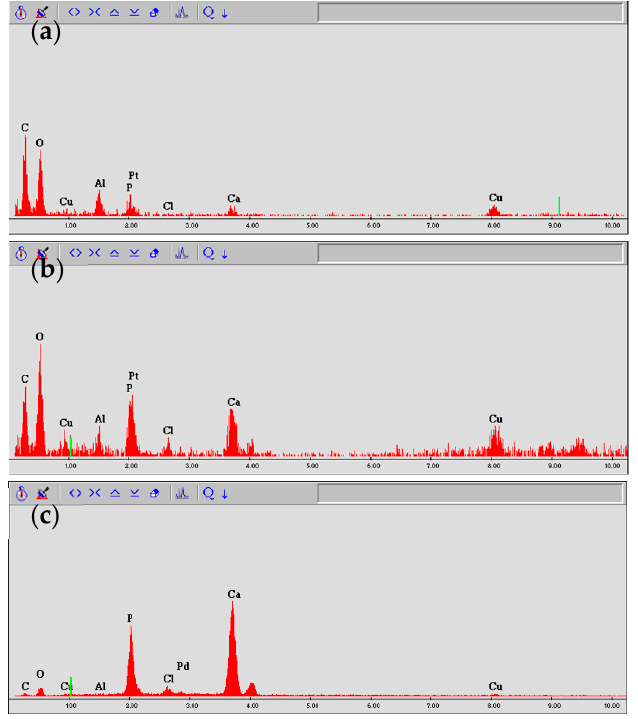
Figure 5. Classi fi cation of simulated root canal walls by EDS spectrum. ( a ) Decalci fi ed surface, ( b ) Figure 5. Classification of simulated root canal walls by EDS spectrum. ( a ) Decalcified surface, dentine surface, and ( c ) mineral surface. ( b ) dentine surface, and ( c ) mineral surface.